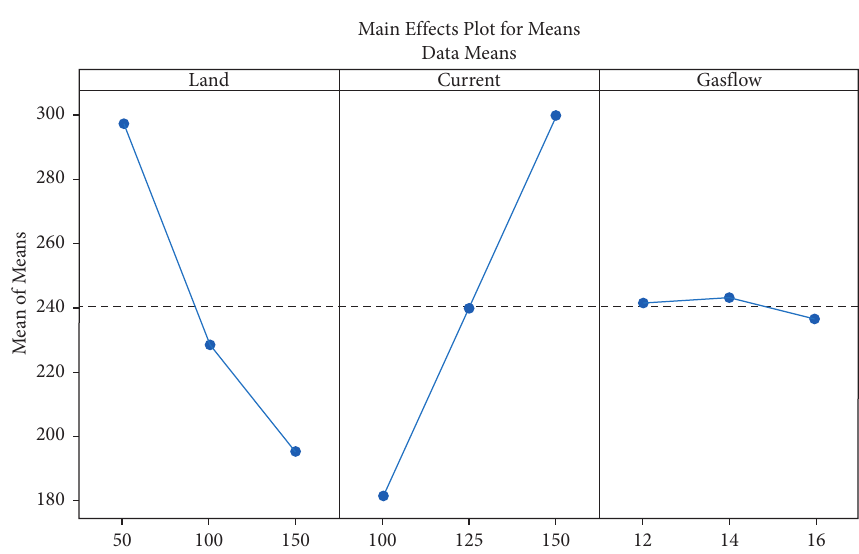
Figure 21: Taguchi analysis for residual stress v/s land, current, and gas flow rate.